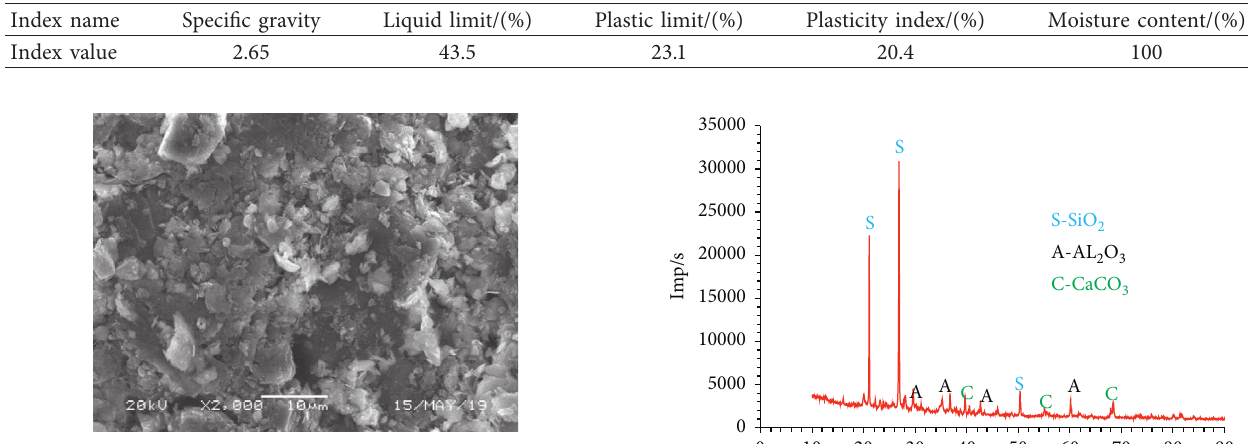
Figure 2: The scanning electron microscopy (SEM) test results of the slurry.